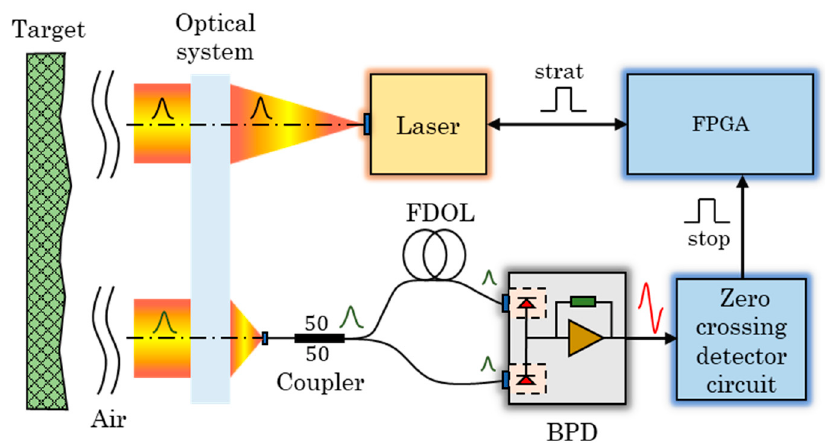
Figure 1. The block diagram of the pulsed TOF lidar system based on BDM.